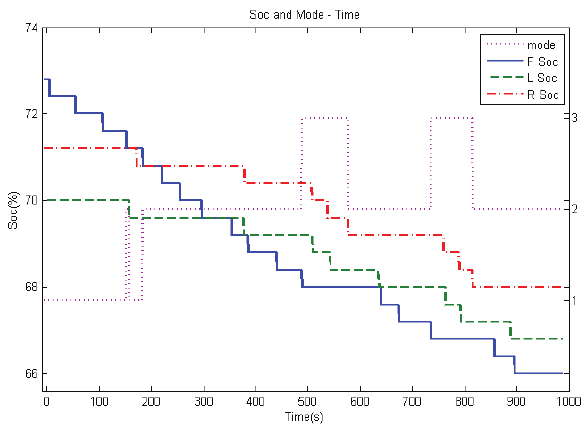
Figure 12. The variation of SOC of the three battery packs in the road test.